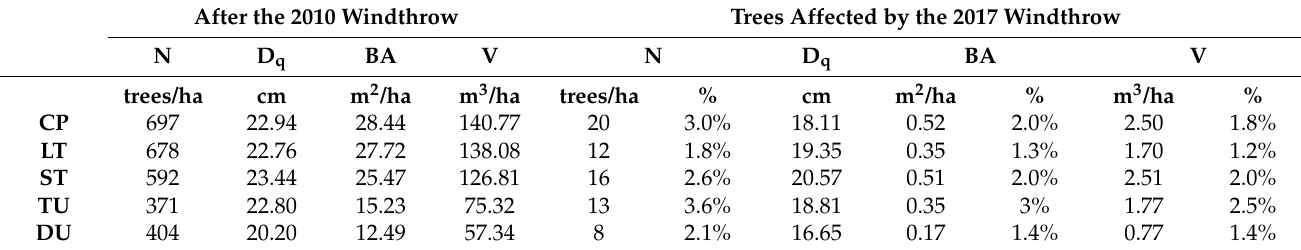
Table 4. Main parameters of the research plots by treatment after the 2010 windthrow and trees affected by the 2017 windthrow.